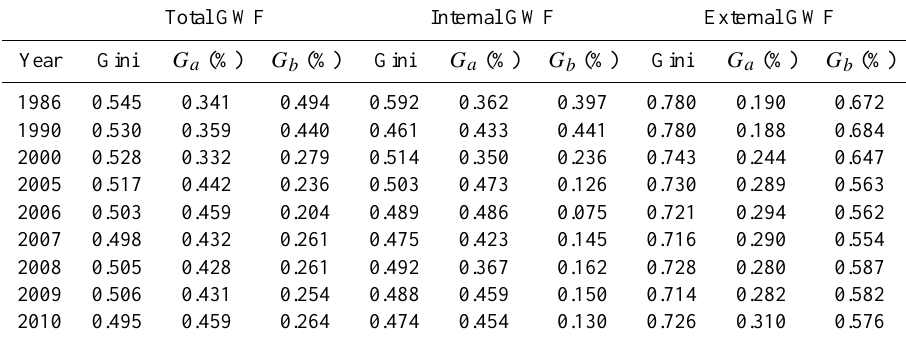
Table 1. Gini coefficients for total, internal, and external grey water footprints (GWF). G a is the proportion of inequality due to differences within social development classes. G b is the proportion of inequality due to differences between social development classes. G a and G b do not sum to unity because some inequality is caused by overlap between classes (Seekell et al., 2011). Total GWF